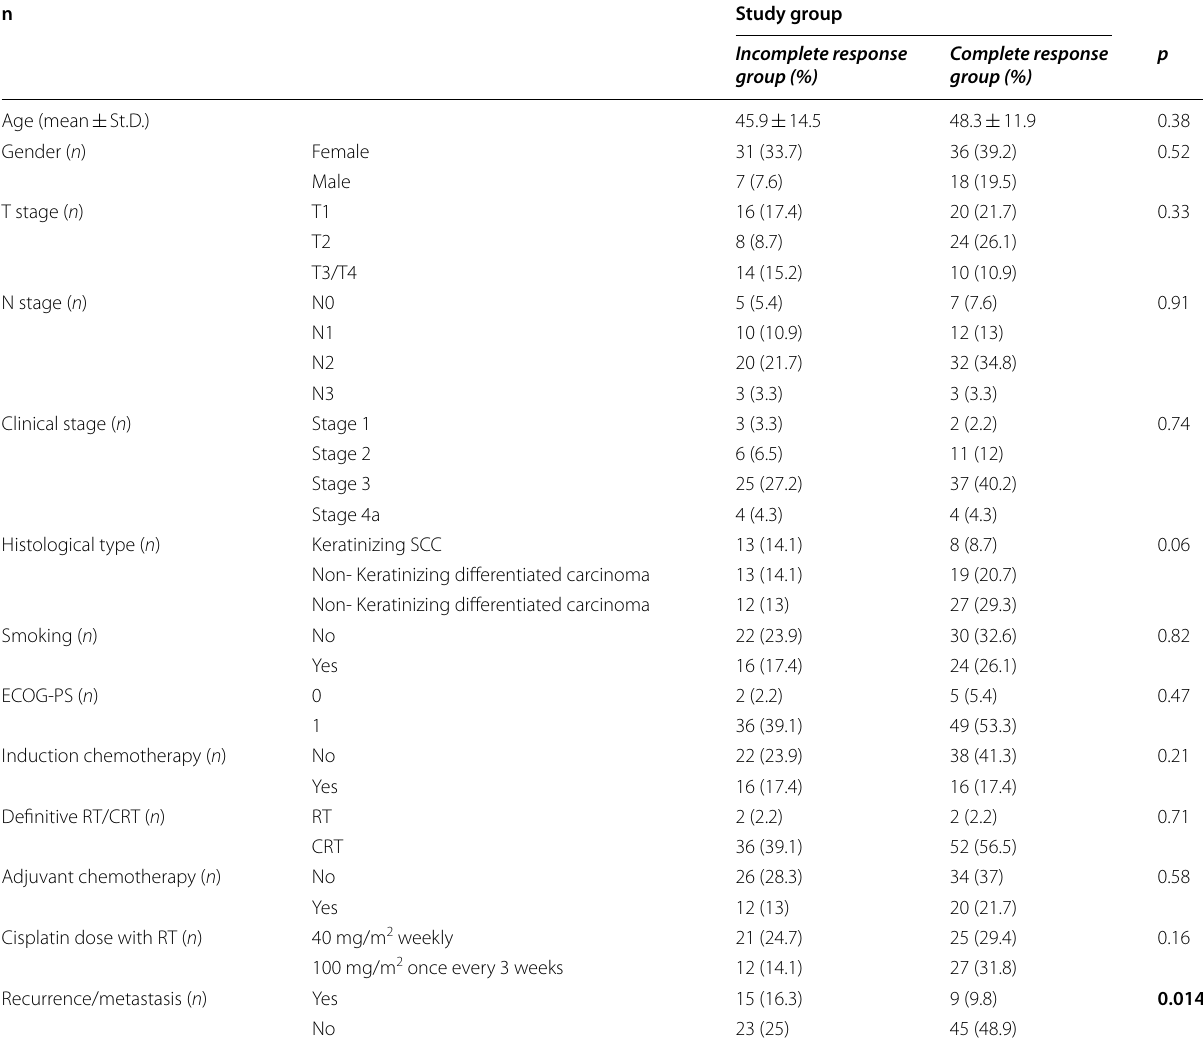
Table 1 Baseline characteristics of complete and incomplete response group in patients with nasopharyngeal